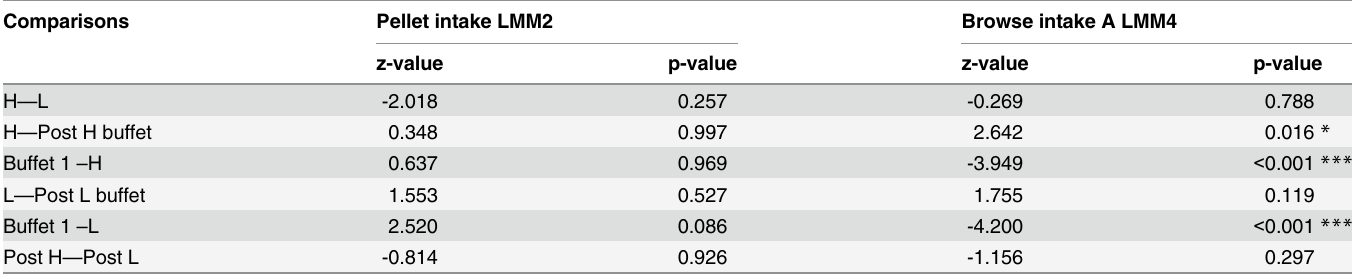
Table 4. Post-hoc test results of the best linear mixed models regarding the relationship between daily pellet and browse intake and dietary treatment. Comparisons